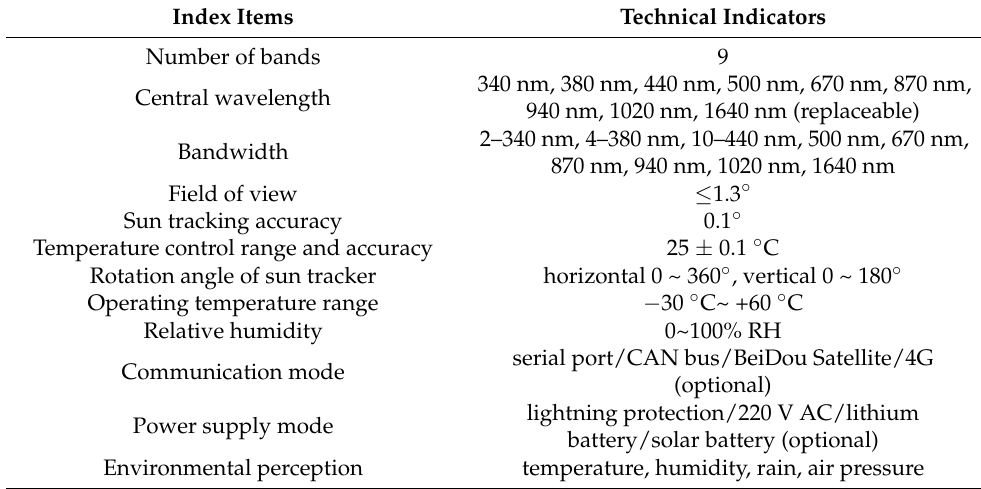
Table 1. Technical parameters of the PSR sun photometer.